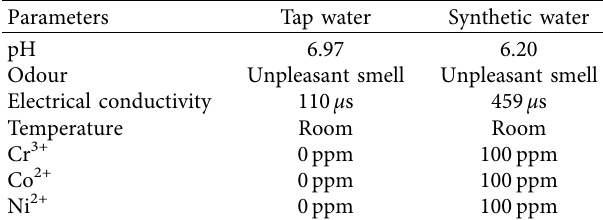
Table 1: Measured characteristics of the tap and synthetic